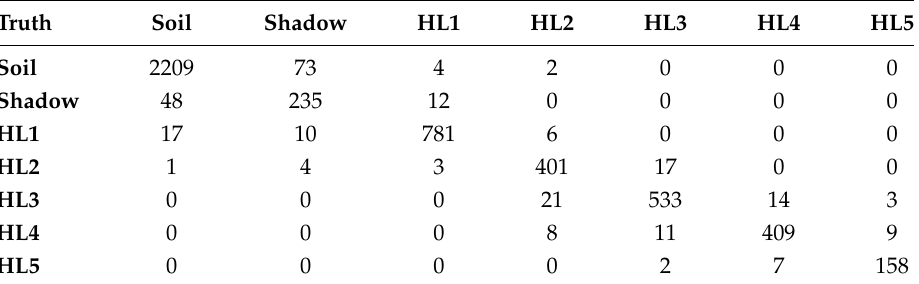
Table 4. Confusion matrix for the maximum likelihood classifier (MLC) segment classes.